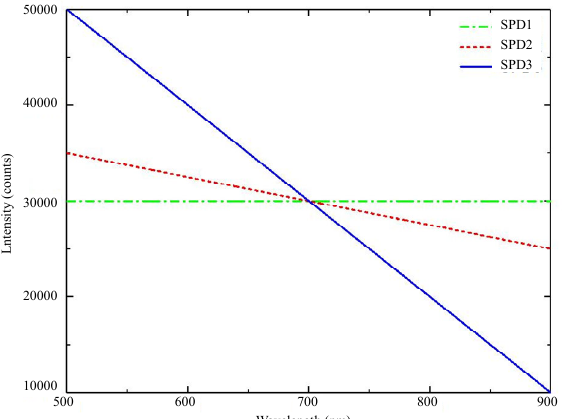
Fig. 3 Three different spectral power distributions are simulated (solid line represents SPD3, short dash line represents SPD2, and dash dot line represents SPD1).